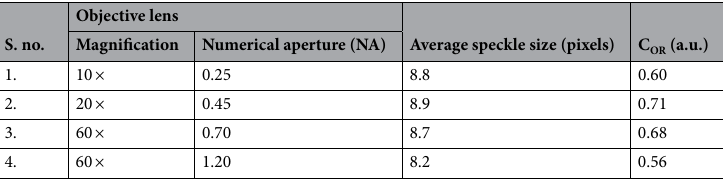
Table 1. Speckle sizes as a function of objective lens magnification and NA.